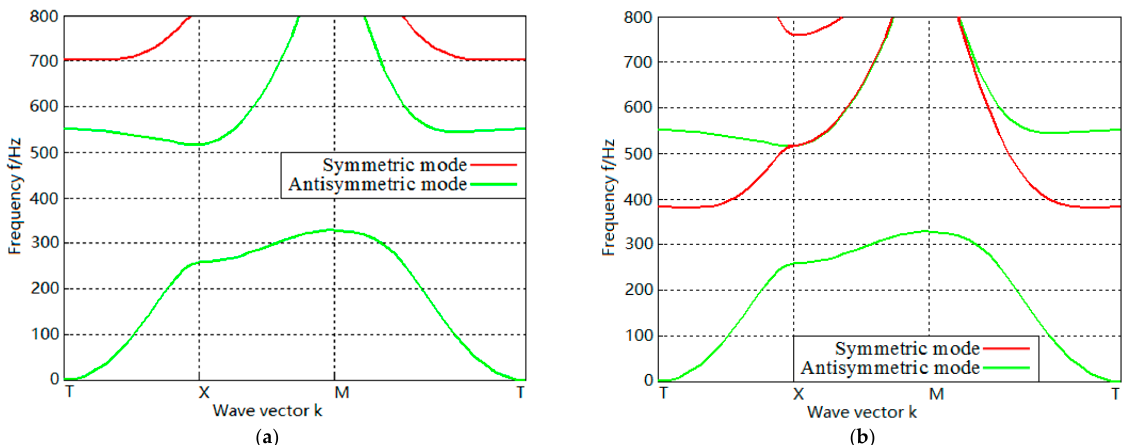
Figure 4. Band structures of simplified models of stubbed ‐ on LRPC DPSs with ( a ) four and ( b ) zero springs surrounded. Table 3. Materials’ parameters used in calculations in Figure 4.